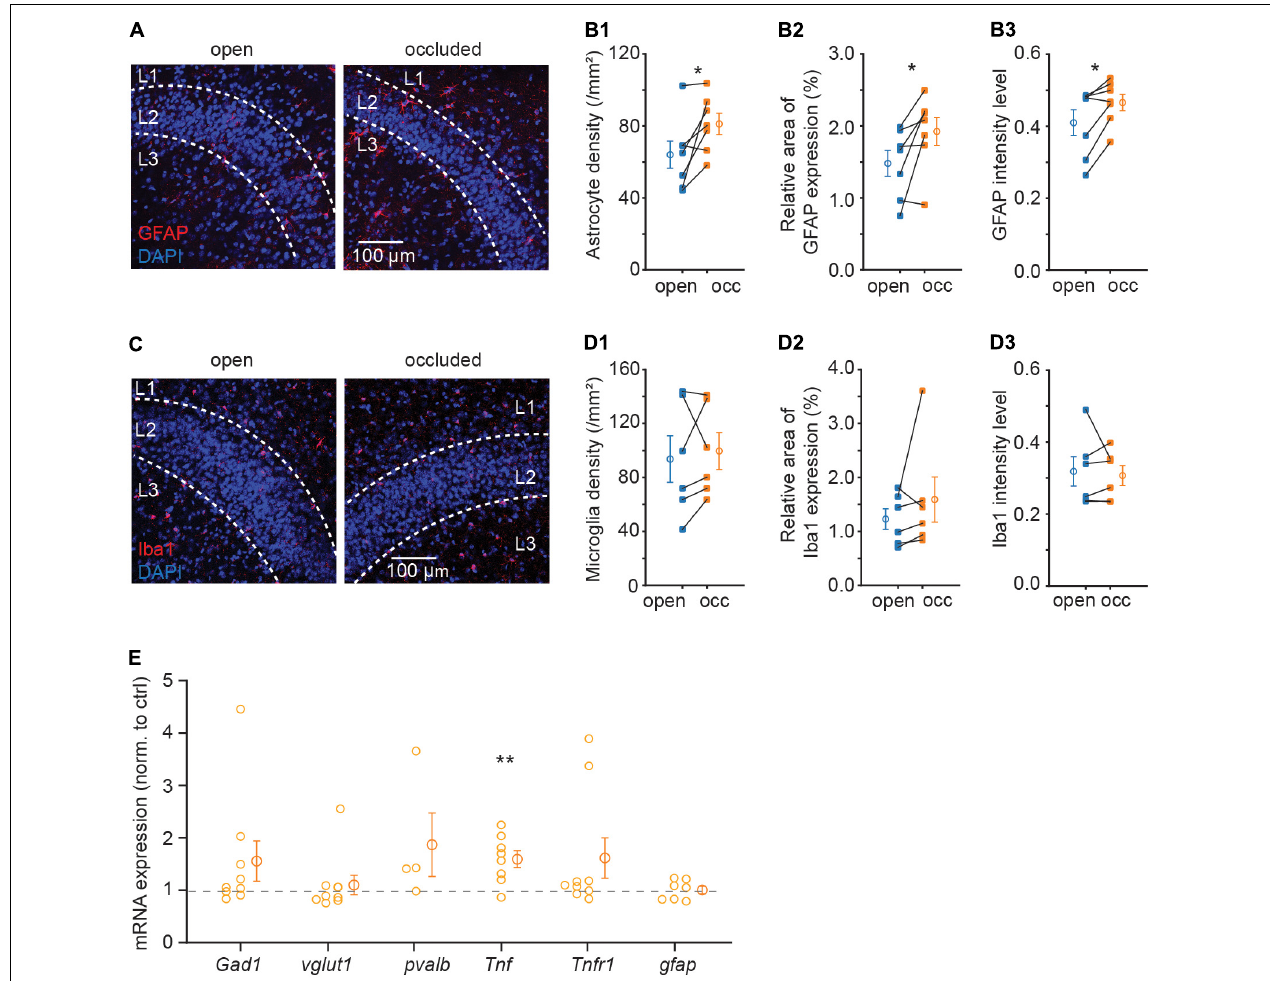
FIGURE 3 | Sensory deprivation increased astrocyte density and expression of TNF- α in APC. (A) Representative images of GFAP in APC. (B) Quantification of astrocyte density (B1) , GFAP relative area of GFAP expression percentage (B2) and mean intensity (B3) in APC. (B1: p = 0.037, B2: p = 0.038, B3: p = 0.031, N = 7) (C) representative images of Iba1 in APC. (D) Quantification of microglia density (D1) , Iba1 relative area of Iba1 expression percentage (D2) and mean intensity (D3) in APC. (D1: p = 0.599, D2: p = 0.313, D3: p = 0.676, N = 6) (E) relative mRNA expression of Gad1 , vglut1 , pvalb , Tnf , Tnfr1, and gfap in the occluded side; foldchange is normalized to open side ( p = 0.185, N = 9; p = 0.601, N = 9; p = 0.246, N = 4; p = 0.008, N = 8; p = 0.149, N = 9; p = 0.953, N = 7). n = 3 repeats of experiments were performed in (A–D) ; n = 2–4 repeats of experiments were performed in (E) . Mann-Whitney test was used for GFAP mean intensity and Iba1 relative area of Iba1 expression percentage. Paired t -test was used for the rest of the